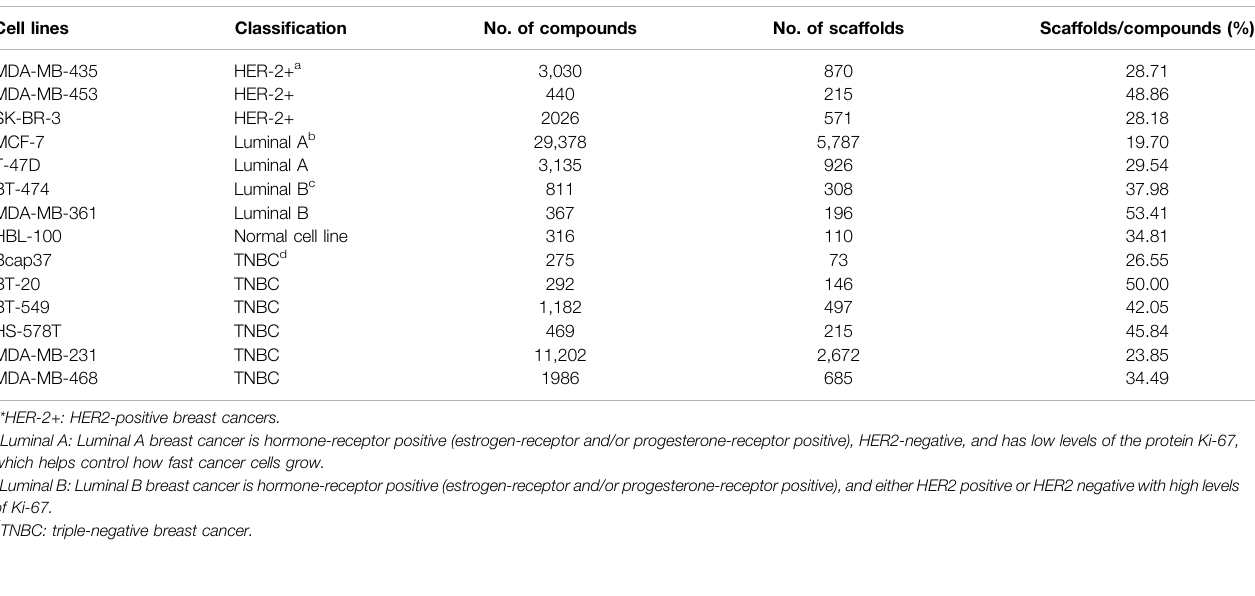
TABLE 1 | Breast cell line datasets used in this study.